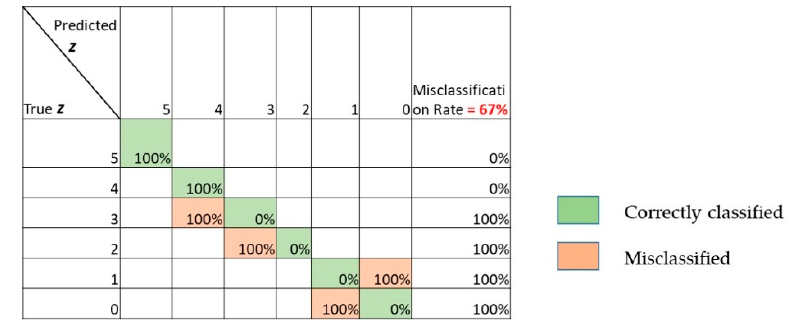
Figure 11. Confusion matrix for the crisp boundary approach.